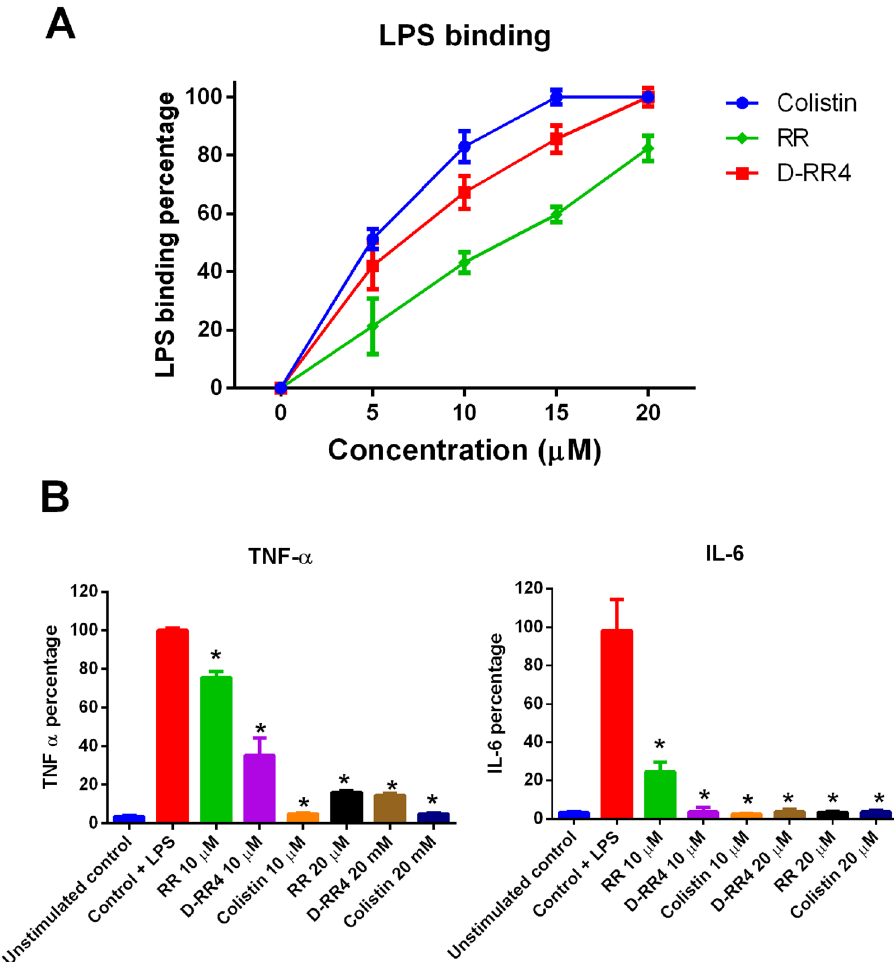
Figure 3. Ability of peptides to neutralize LPS and reduce inflammatory cytokines expression. ( A ) LPS binding activity of peptides. Peptides at different concentrations were incubated with one endotoxin unit (EU) of LPS at 37 °C for 30 minutes. Colistin was used as a positive control due to its high binding affinity for LPS. The binding of peptides with LPS is expressed as percent change relative to the untreated samples. ( B ) Anti-inflammatory effect of peptides on LPS-stimulated macrophages. J774A.1 cells were stimulated with LPS (150 ng/mL final concentration) in the presence of different concentrations of peptides. Cells stimulated with LPS alone and untreated cells served as controls. Cells were incubated for six hours at 37 °C before the supernatant from each treatment group was collected. Detection of tumor necrosis factor- α (TNF- α ) and interleukin-6 (IL-6) in supernatants was determined using ELISA. Cytokine levels are expressed as percent change relative to the LPS- stimulated control. Statistical analysis was calculated using one-way ANOVA, with post hoc Tukey’s multiple comparisons test. P < 0.05 was considered significant. One asterisk ( * ) indicates significant difference with the negative